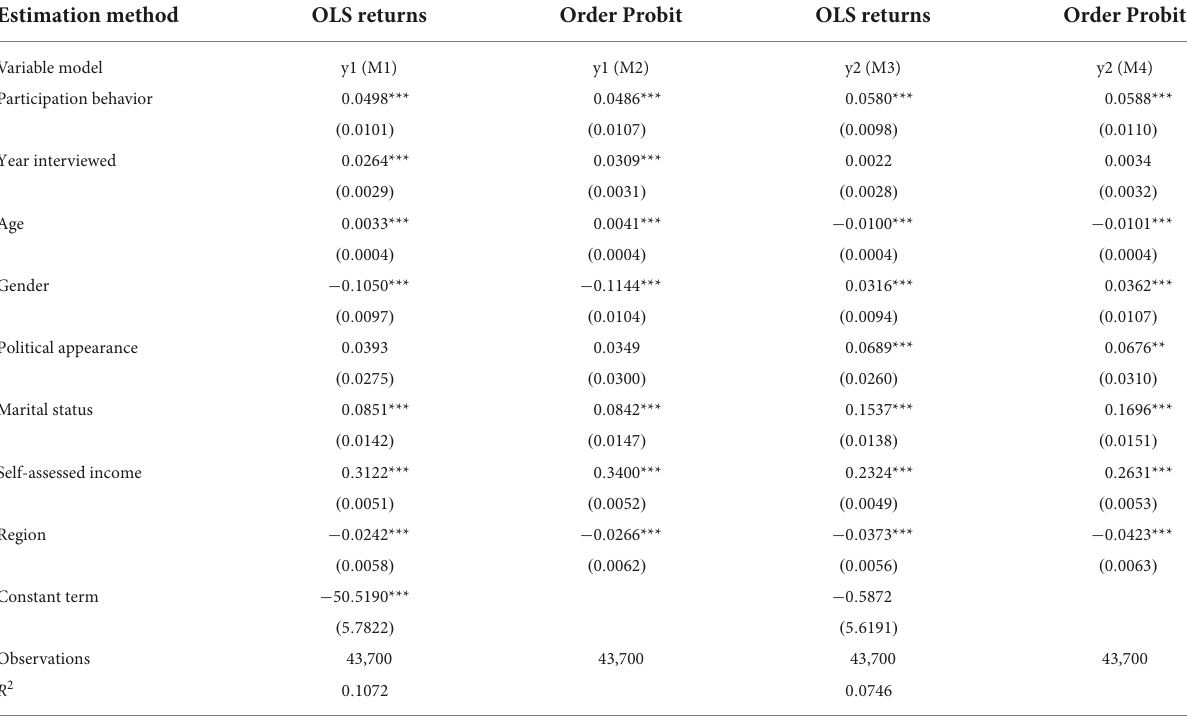
TABLE 3 Results of the effect of social insurance on farmers’ perception of subjective well-being. a